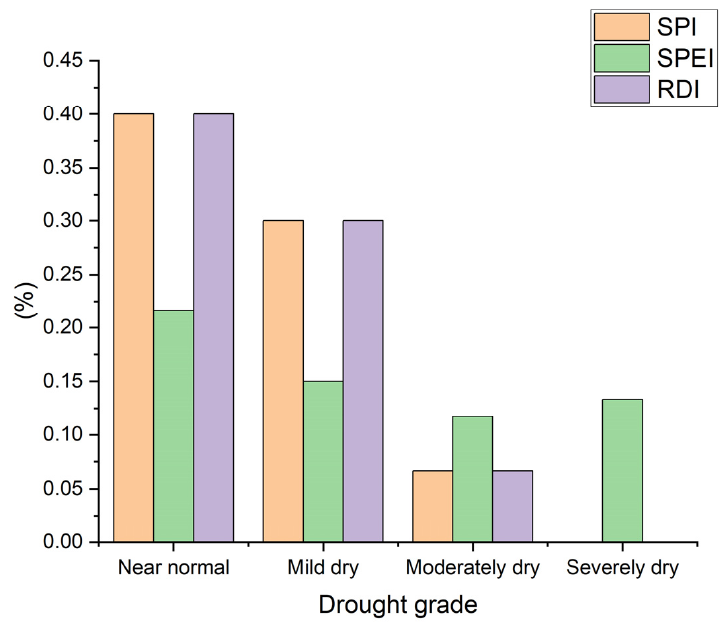
Figure 8. Drought grade for Turpan region annual scale from1960–2019.